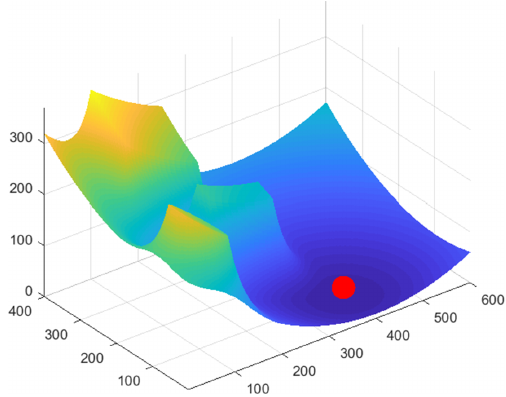
Figure 11. Composite potential field of obstacle and target point.